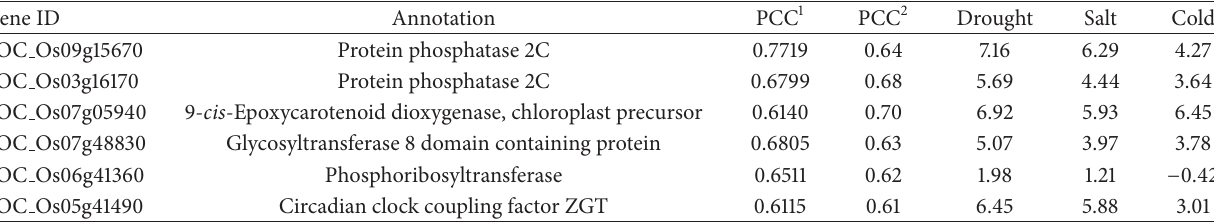
Table 1: List of genes coexpressed with OsSLI1 .